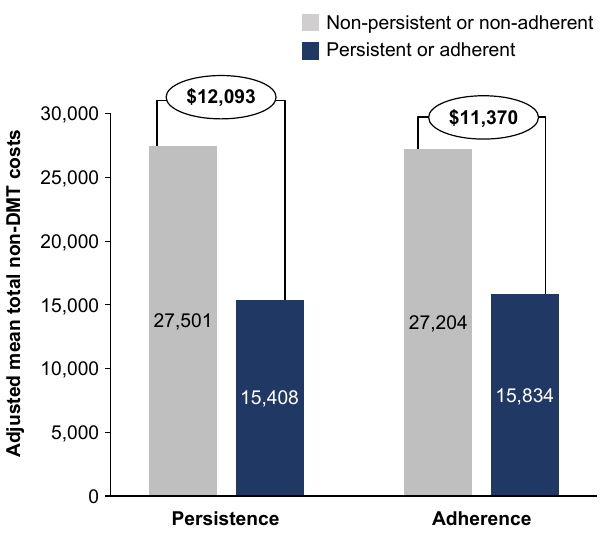
Figure 2. Adjusted MS-Related Non-DMT Costs at 24 Months in Nonpersistent vs Persistent Patients and Nonadherent vs Adherent